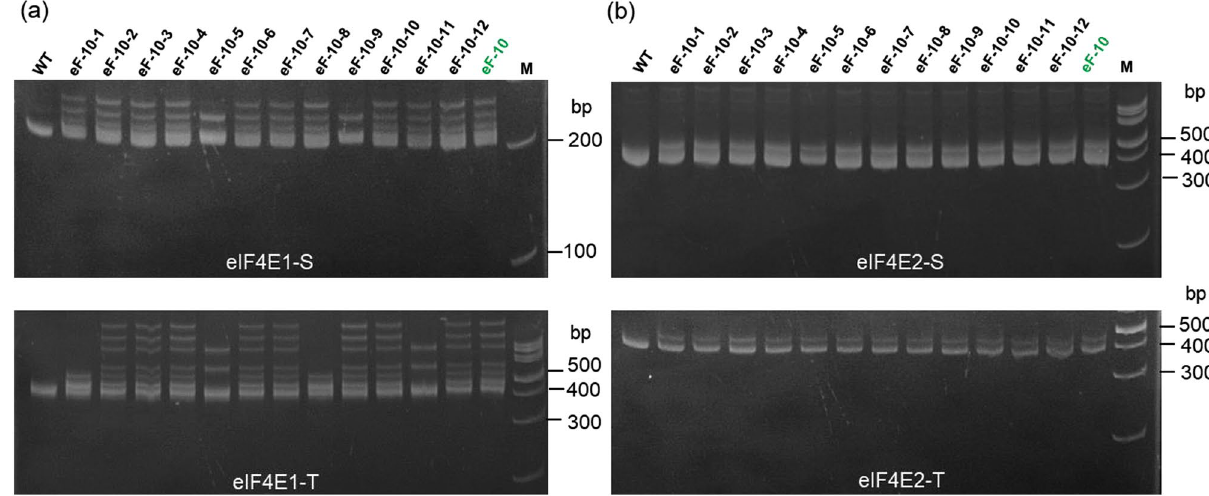
Figure 5. Inheritance of induced mutations at T1 generation of the eF-10 mutant line. ( a , b ) PAGE-based heteroduplex analysis of eIF4E1 and eIF4E2 , respectively; eF-10: T0 mutant line. eF-10–1–eF-10–12: T1 offspring of T0 eF-10 line. WT wild type plant, M marker 100 bp, Thermo